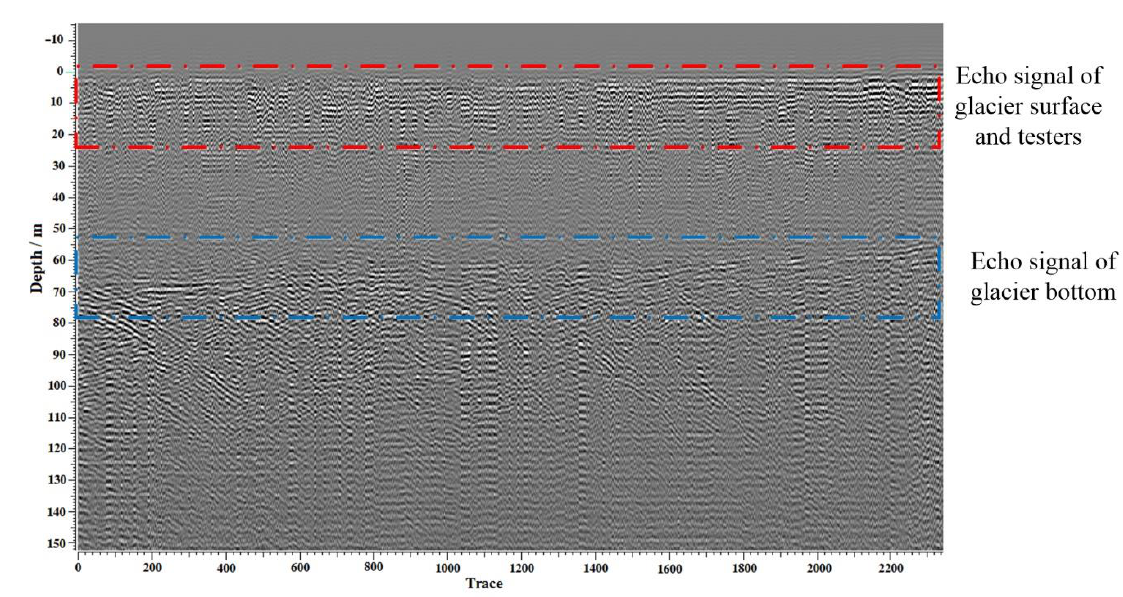
Figure 13. Results of the verification test. The red dotted box shows the echoes of the surface of the glacier and the testers, and the blue dotted box shows the echoes of bedrock.